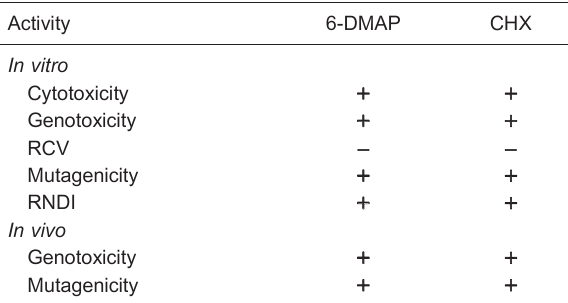
Table 6. Summary of 6-DMAP and CHX